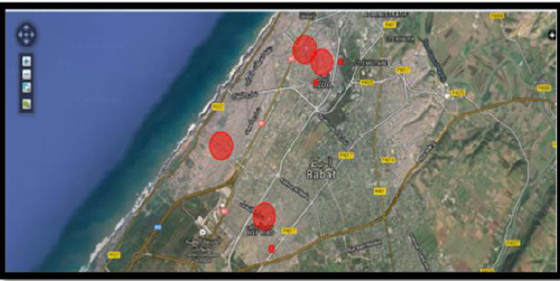
Figure 8: Image Satellite Displaying data : areas of the red dots representing each BTS is proportional to the annual traffic intensity recorded for each of the